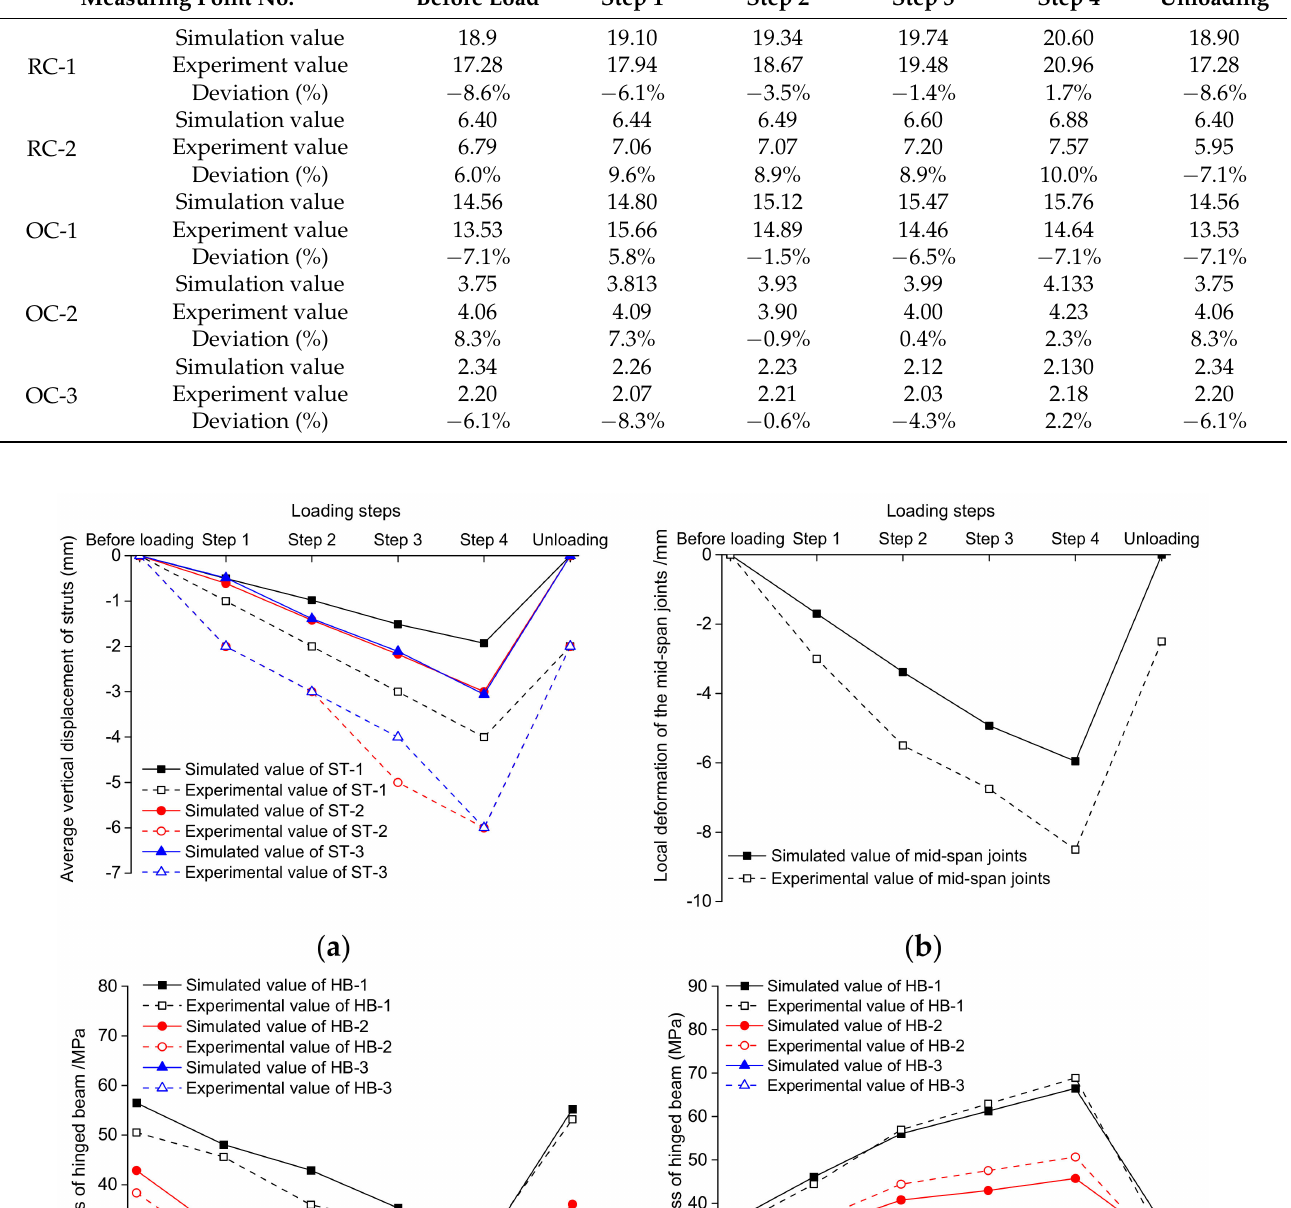
Table 6. Variations in the average cable forces of the full-span static loading test (unit: kN). Measuring Point No.